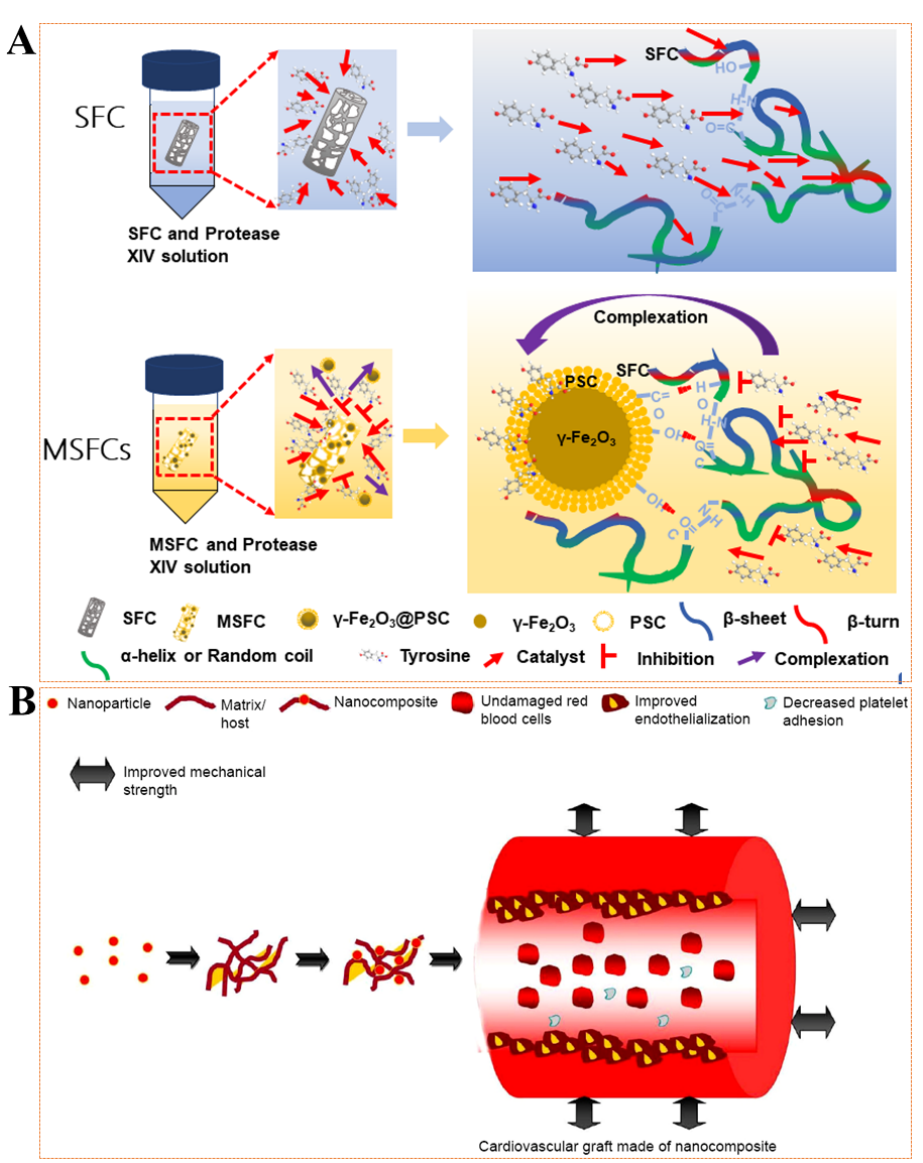
Figure 3. ( A ) Significantly delayed degradation of silk fibroin scaffolds (SFC) loaded with MNPs. Reprinted with permission from ref. [16]. ( B ) Using nanocomposites to improve the performance of